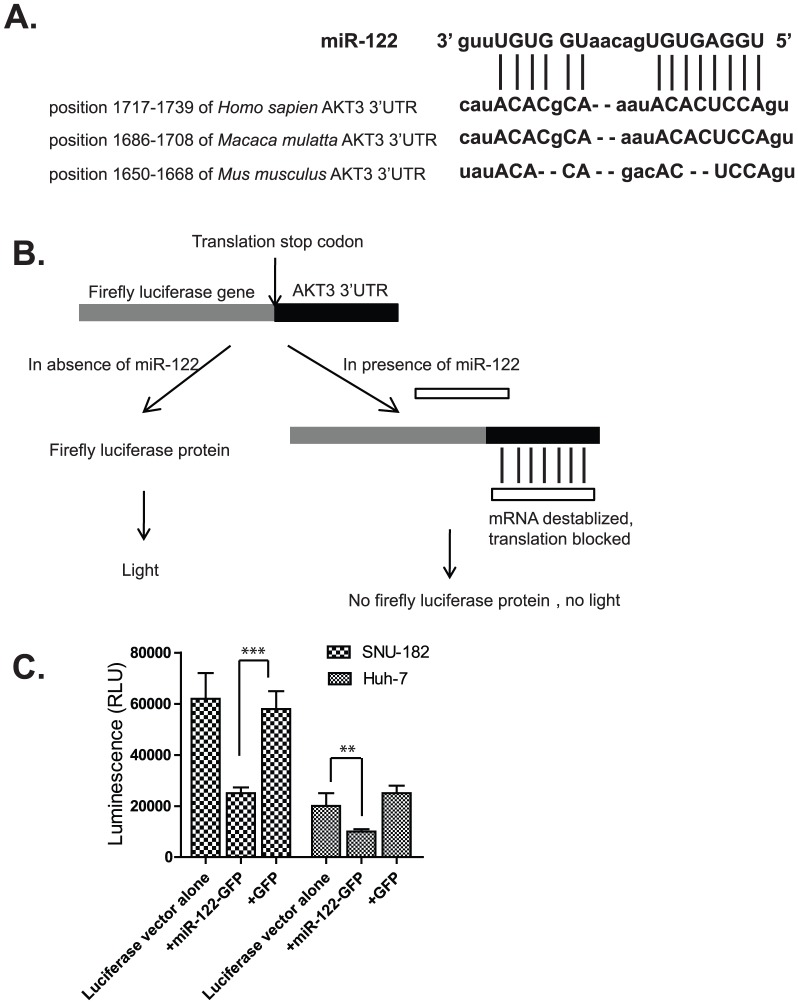
miR-122 directly binds to the 3’UTR of hsa-AKT3.(A) Sequence alignments of miR-122 with 3’UTR of AKT3 from 3 mammalian species shows partial complementarity. (B) Schematic representation describing the 3’UTR luciferase reporter assay. The assay was carried out simultaneously in SNU-182 and Huh-7 cells, over-expressing miR-122 GFP or the GFP vector alone, as well as parental cells co-transfected with the pGL3-3’UTR construct containing AKT3 3’UTR. Luciferase assays were performed 48 hours after transfection using the Dual-Luciferase Reporter Assay System (Promega). Firefly luciferase activity was normalized to Renilla luciferase activity to account for variations in transfection efficiency. Firefly luciferase activity will be reduced if there is a direct binding between miR-122 and the 3’UTR of AKT3 sequence inserted in the vector. (C) Luciferase activity was measured in SNU-182 and Huh-7 parental, miR-122-GFP and GFP over-expressing cells transfected with the luciferase reporter 3’UTR construct or vector alone. Results represent at least three different independent experiments, and statistical significance between indicated groups is depicted as ** P<0.01, *** P<0.005.